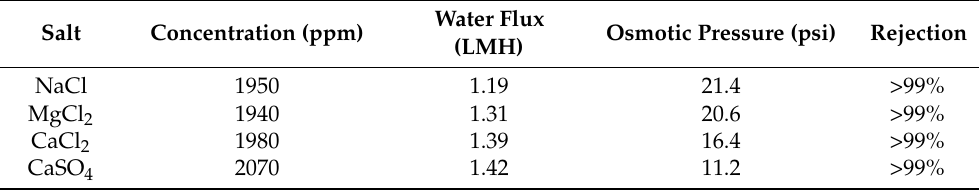
Table 2. Initial Membrane Screening–Water Flux and Salt Rejection.